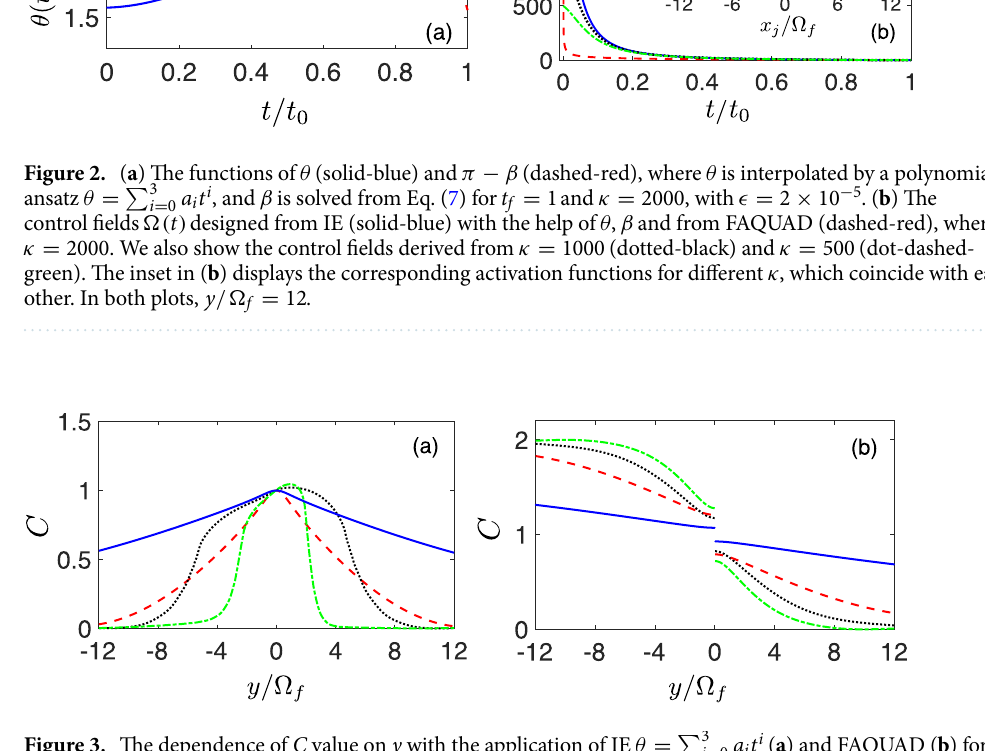
0.1 (solid-blue), t =